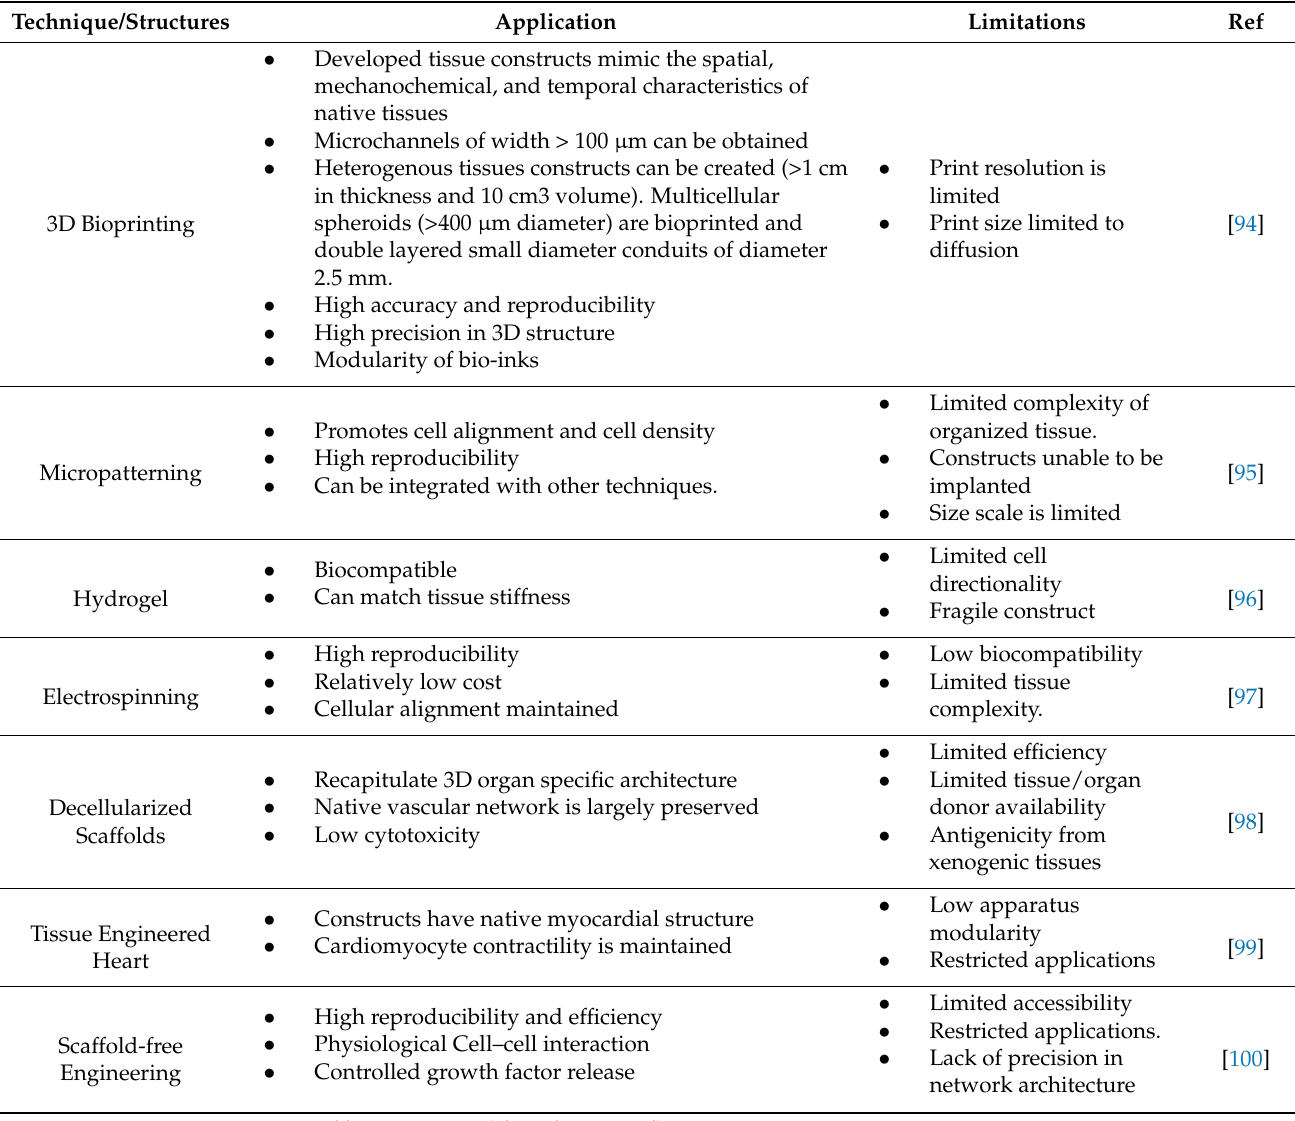
Table 4. Fabrication techniques/structures to promote vascularization in tissue engineered